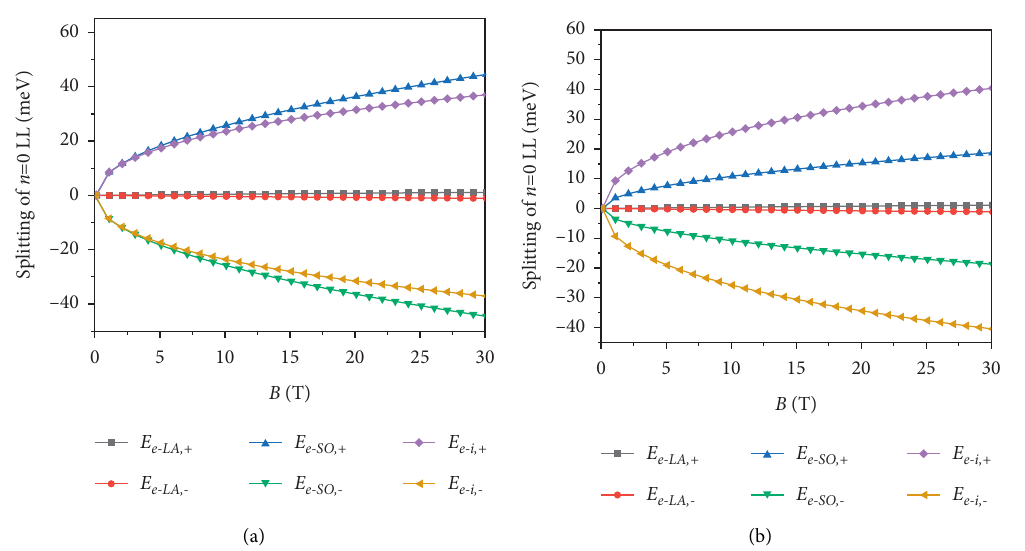
Figure 2: Relations between the splitting of n � 0 LL and magnetic field B for SiO